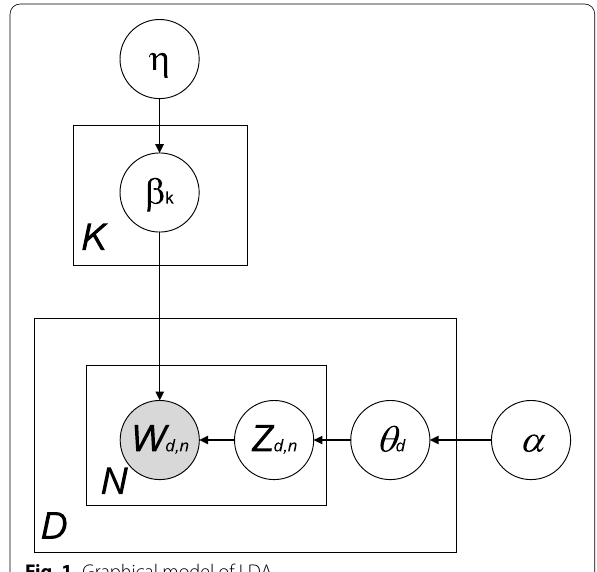
Fig. 1 Graphical model of